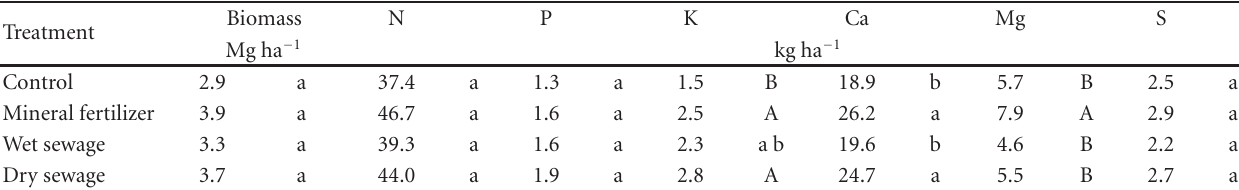
Table 7: Mean dry matter and nutrient amounts in the leaf litter accumulated on the soil surface in each treatment (average for the four seasons, the third year after planting).